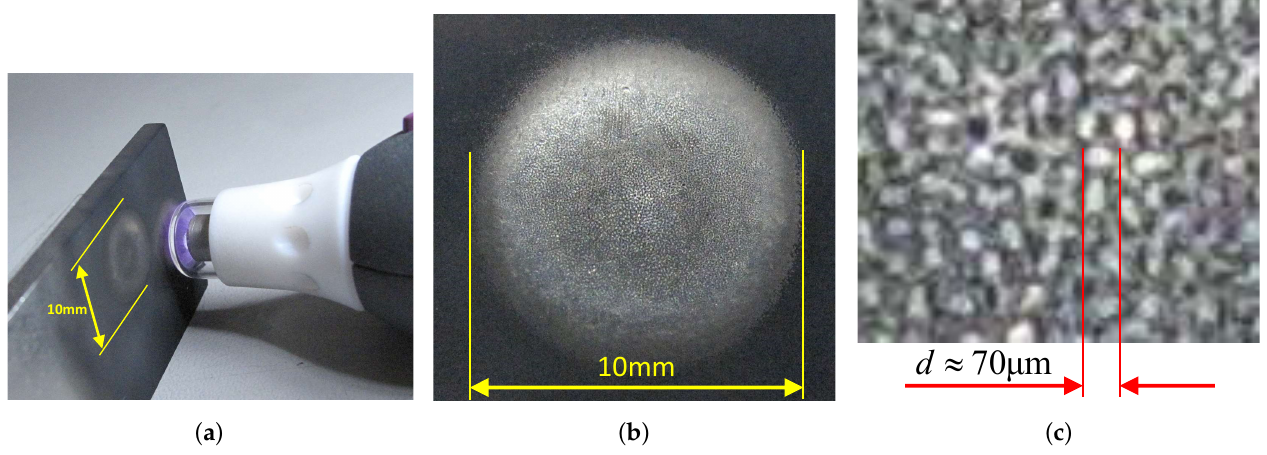
Figure 17. Soot removal from the surface of a stainless-steel substrate using the piezobrush ® PZ2 with the near-field nozzle (NFN). ( a ) the picture of the DBD discharge during treatment; ( b ) the pattern eroded in the soot film during the 30 s treatment; ( c ) the magnification of the eroded soot film with depicted size of a single erosion spot.